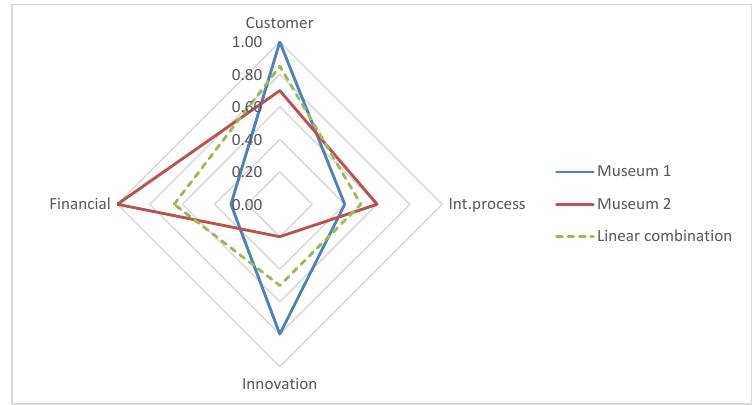
Figure 8. Radar chart showing a representative diamond of the BSC perspective scores for the museums of Example 2.